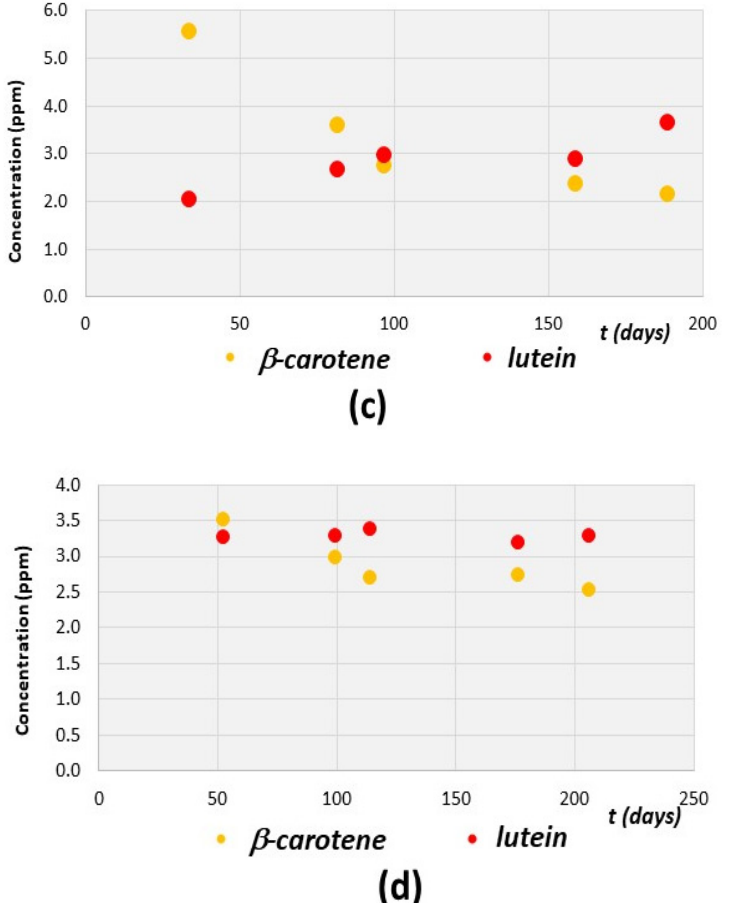
Figure 10. Trends of the concentration (ppm) of β -carotene (yellow circles) and lutein (red circles) during time (t) expressed in days of several fresh EVOO samples. Data are obtained from the deconvolution of the experimental spectra. Data refer to ( a ) sample A, ( b ) sample C, ( c ) sample D, and ( d ) sample E.